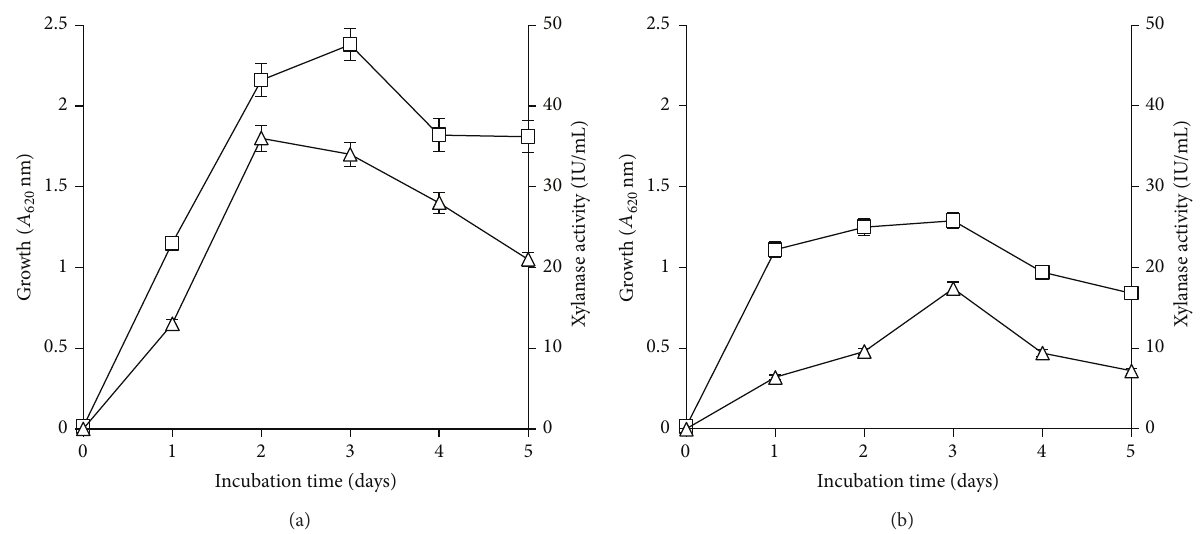
Figure 2: Growth ( ◻ ) and xylanase ( △ ) production by strain X1 in wheat bran (a) and xylan medium (b) at 35 ∘ C, pH 8.0 and shaking at 120 rpm.